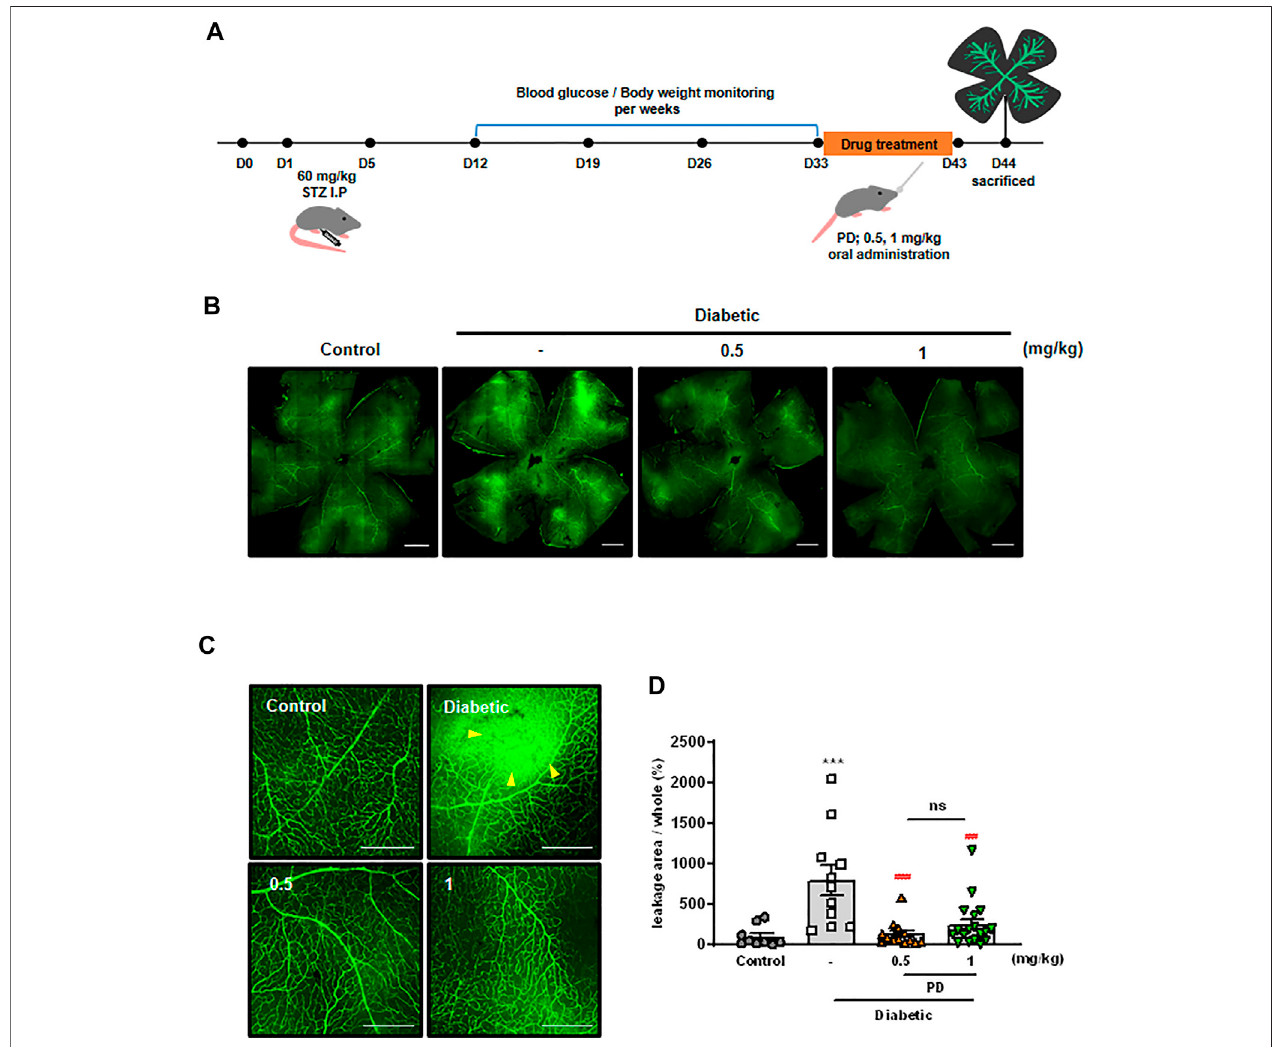
FIGURE 3 | Oral administration of PD attenuates diabetes-induced vascular retinal leakage. (A) Scheme of PD treatment on STZ-induced diabetic mouse model. DiabeticmiceweretreatedwithvariousconcentrationsofPD(0.5and1 mg/kg)for10 daysbyoralgavage;24 hafterthelasttreatment,200 μ LFITC-Dextran(30 mg/ml in sterile PBS) was injected into the left ventricle. Retinas were viewed using confocal microscopy. (B) Representative images for fl uorescein angiography from the control,untreatedDM,andPD-treatedDMgroupsat4 weeksafterSTZinjectionareshownat × 100magni fi cation. (C) Representativeimagesareenlargedimages in (B) , × 200magni fi cation.Yellowarrowheadsindicatetheregionofvascularpermeability. (D) Thequanti fi edstatisticalanalysisoftheareaofFITC-dextranleakagein (B) is shown by multi-gauge software (Fuji). Data are the mean ± SEM. *** p < 0.0005vs control group; ### p < 0.0005, #### p < 0.0001 vs vehicle group (n > 9). Scale bar (cid:2) 500 μ